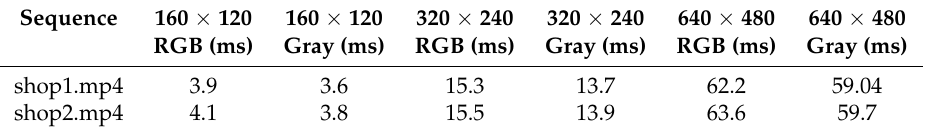
Table 4. Time (in ms) to process the background subtraction on one frame depending on the video sequence and the resolution (rectangle aspect ratio), using the ZedBoard (CPU+FPGA).